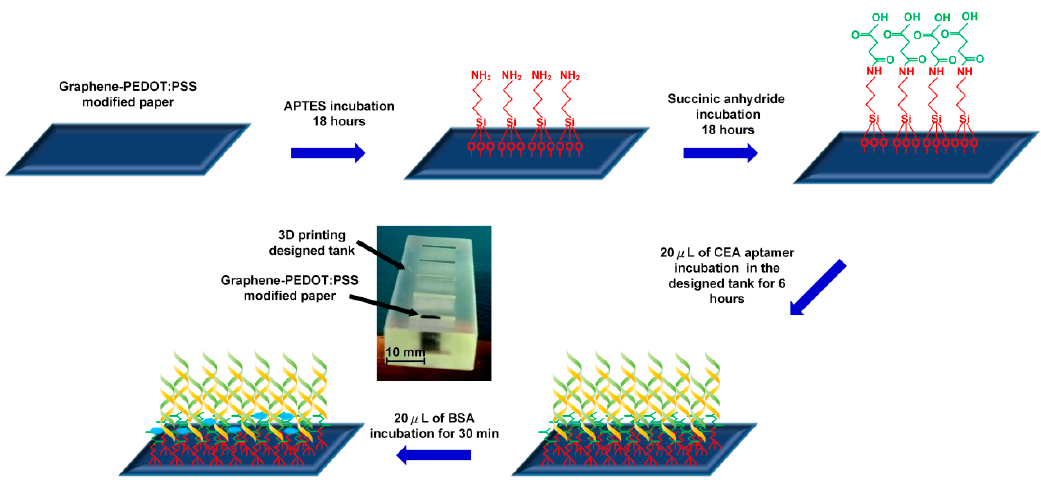
Figure 1. Surface functionalization process of the conductive paper-based electrochemical aptasensor.